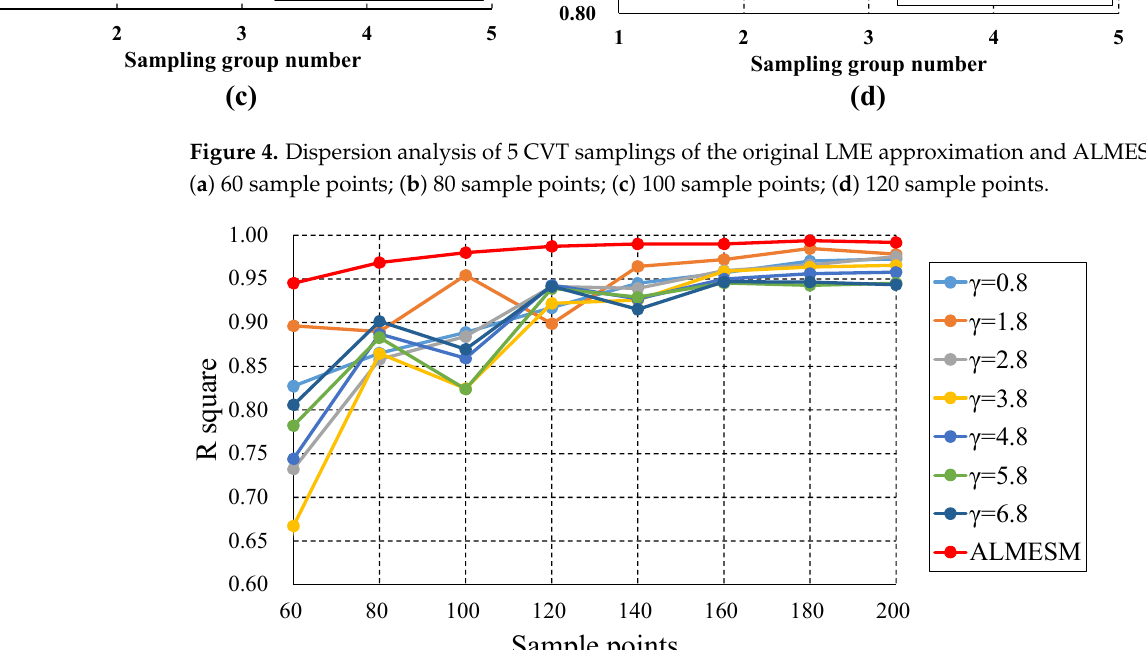
Figure 5. R-squared comparison of ALMESM, and the original LME approximation with different globally unified γ under different number of sample points in the 3-D function. Table 3. Experimental designs for all test problems.